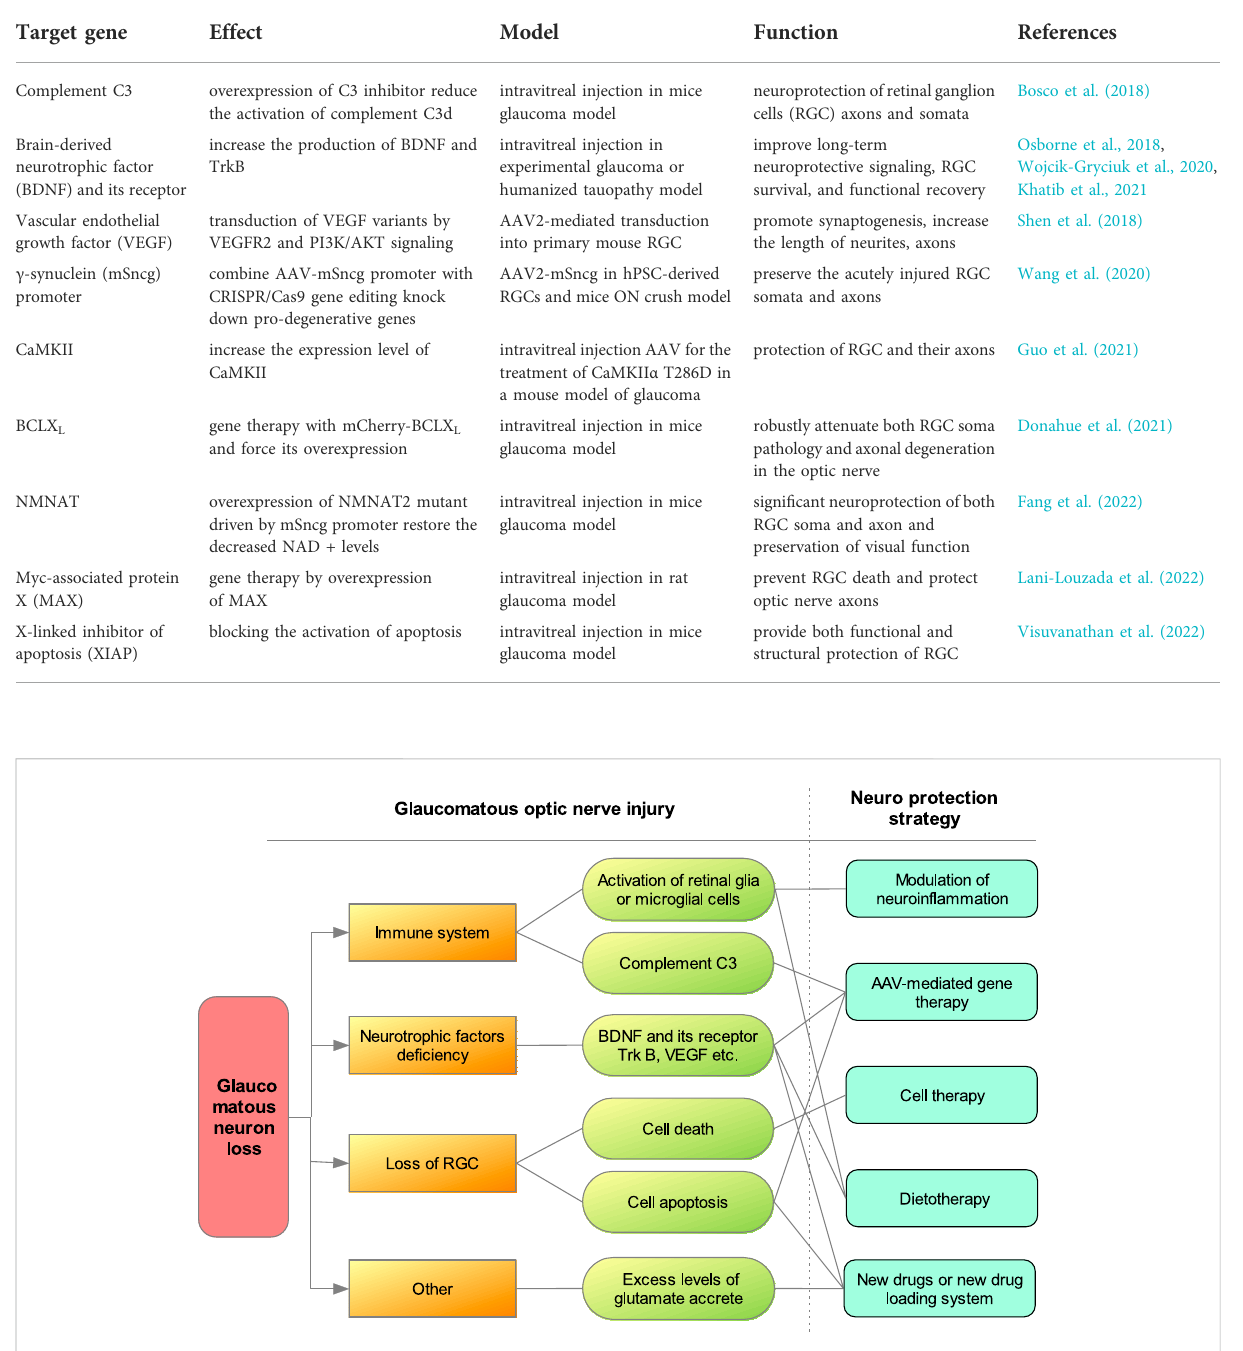
TABLE 1 Gene therapy studies on neuroprotection of glaucoma in recent 5 years.